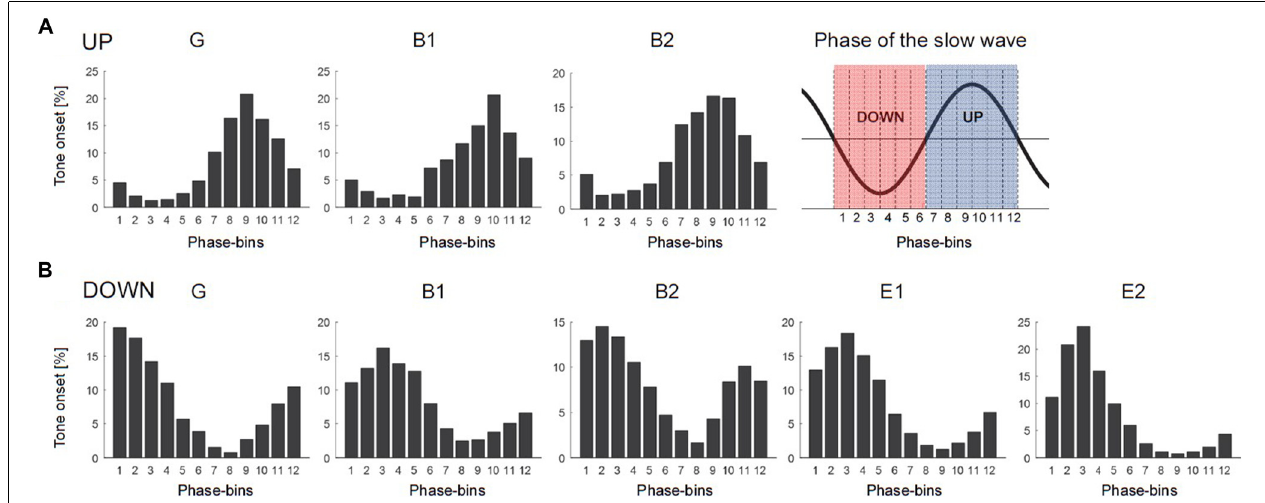
FIGURE 3 | Distribution of tone onset relative to the slow wave oscillation of each subject presented separately for the UP stimulation (A) and the DOWN stimulation (B) . The phase of the slow wave oscillation was subdivided into 12 30 ◦ phase-bins (see graphical illustration in the upper right corner, red: phase-bin 1–6 corresponding to the down-phase, blue: phase-bin 7–12 corresponding to the up-phase). The mean percentage of tone onset allocated during each 30 ◦ phase-bin is shown. Note the variability of tone onset allocation across subjects (G, generalized spike waves in sleep EEG; B, BECTS; E,